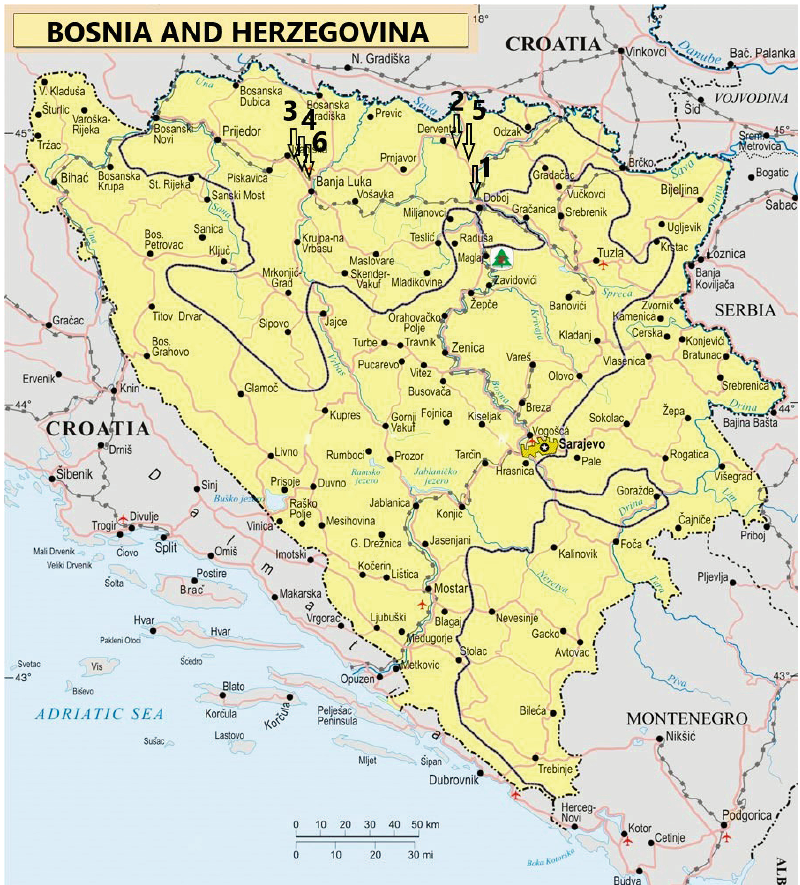
Figure 1. Measuring locations with the longitudinal downgrade in Bosnia and